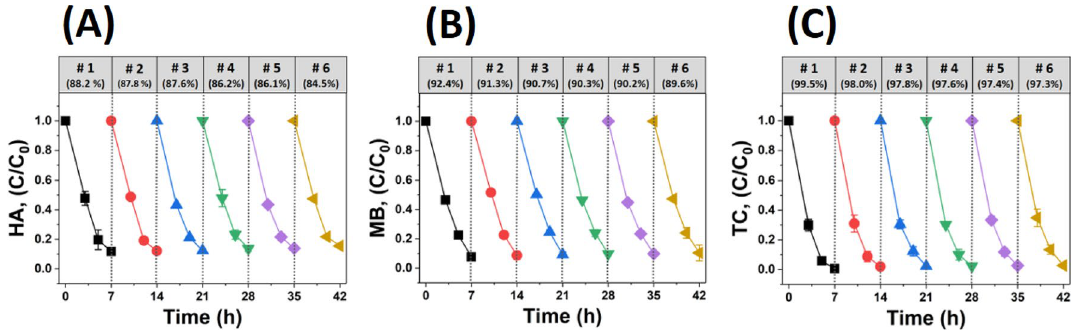
Figure 8. Recycling of ( A ) HA, ( B ) MB, and ( C ) TC by 1.0 M TiO 2 -coated YSZ/silica NF under UV-light